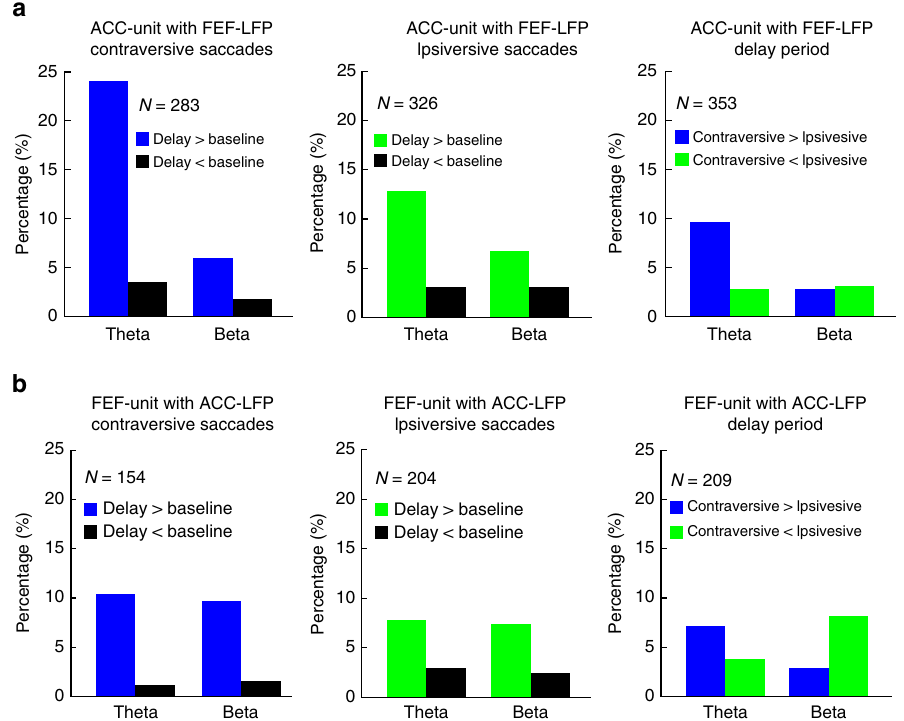
Figure 5 | Percentage of units with significant spike-field coupling in theta and beta band. ( a ) Percentage of the ACC-unit with FEF-LFP pairs showing significant changes in phase locking across the theta and beta frequency range. Comparison between baseline and delay of contraversive saccades (left), comparison between baseline and delay of ipsiversive saccades (middle), and comparison between the contra- and ipsiversive saccades in the delay period (right). ( b ) Same as in a , but now depicted the percentage of the FEF-unit with ACC-LFP pairs showing significant changes in phase locking across the theta and beta frequency range. Statistical testing was performed using two-sided permutation tests, such that chance level is 2.5%.